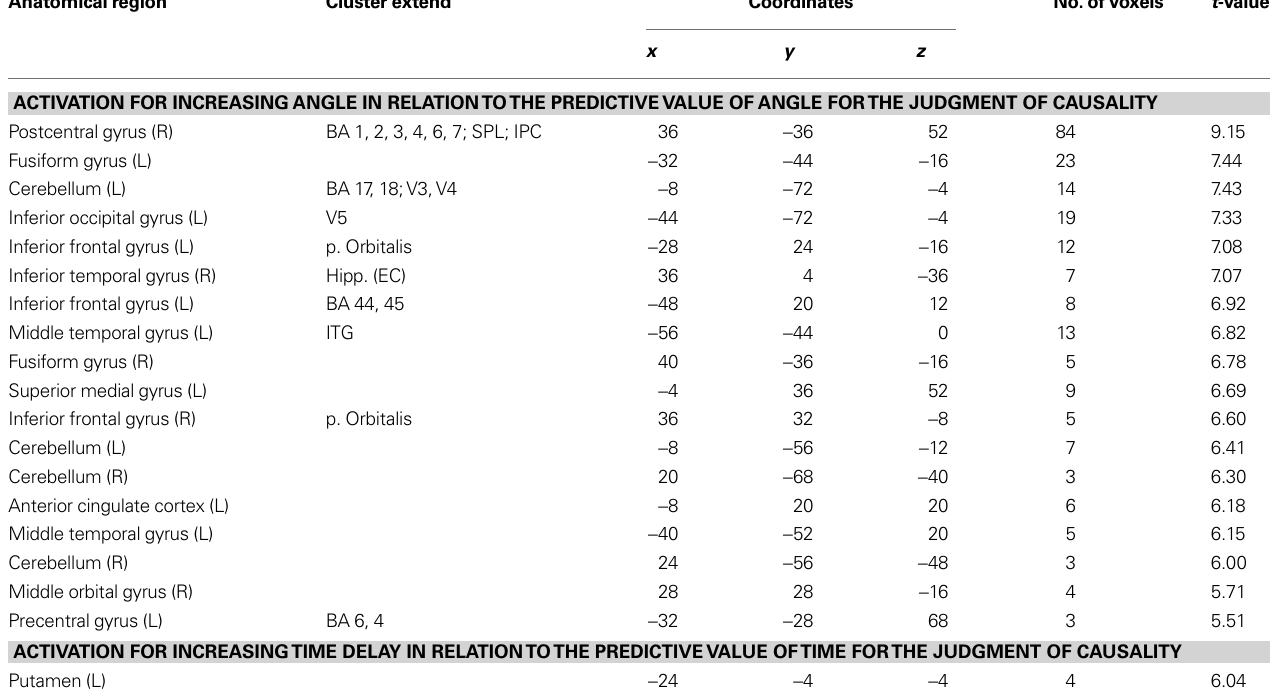
Table 1 | Activations related to logistic regression parameters. Anatomical region Cluster extend Coordinates No. of voxels t -value x y z ACTIVATION FOR INCREASING ANGLE IN RELATION TO THE PREDICTIVE VALUE OF ANGLE FOR THE JUDGMENT OF CAUSALITY